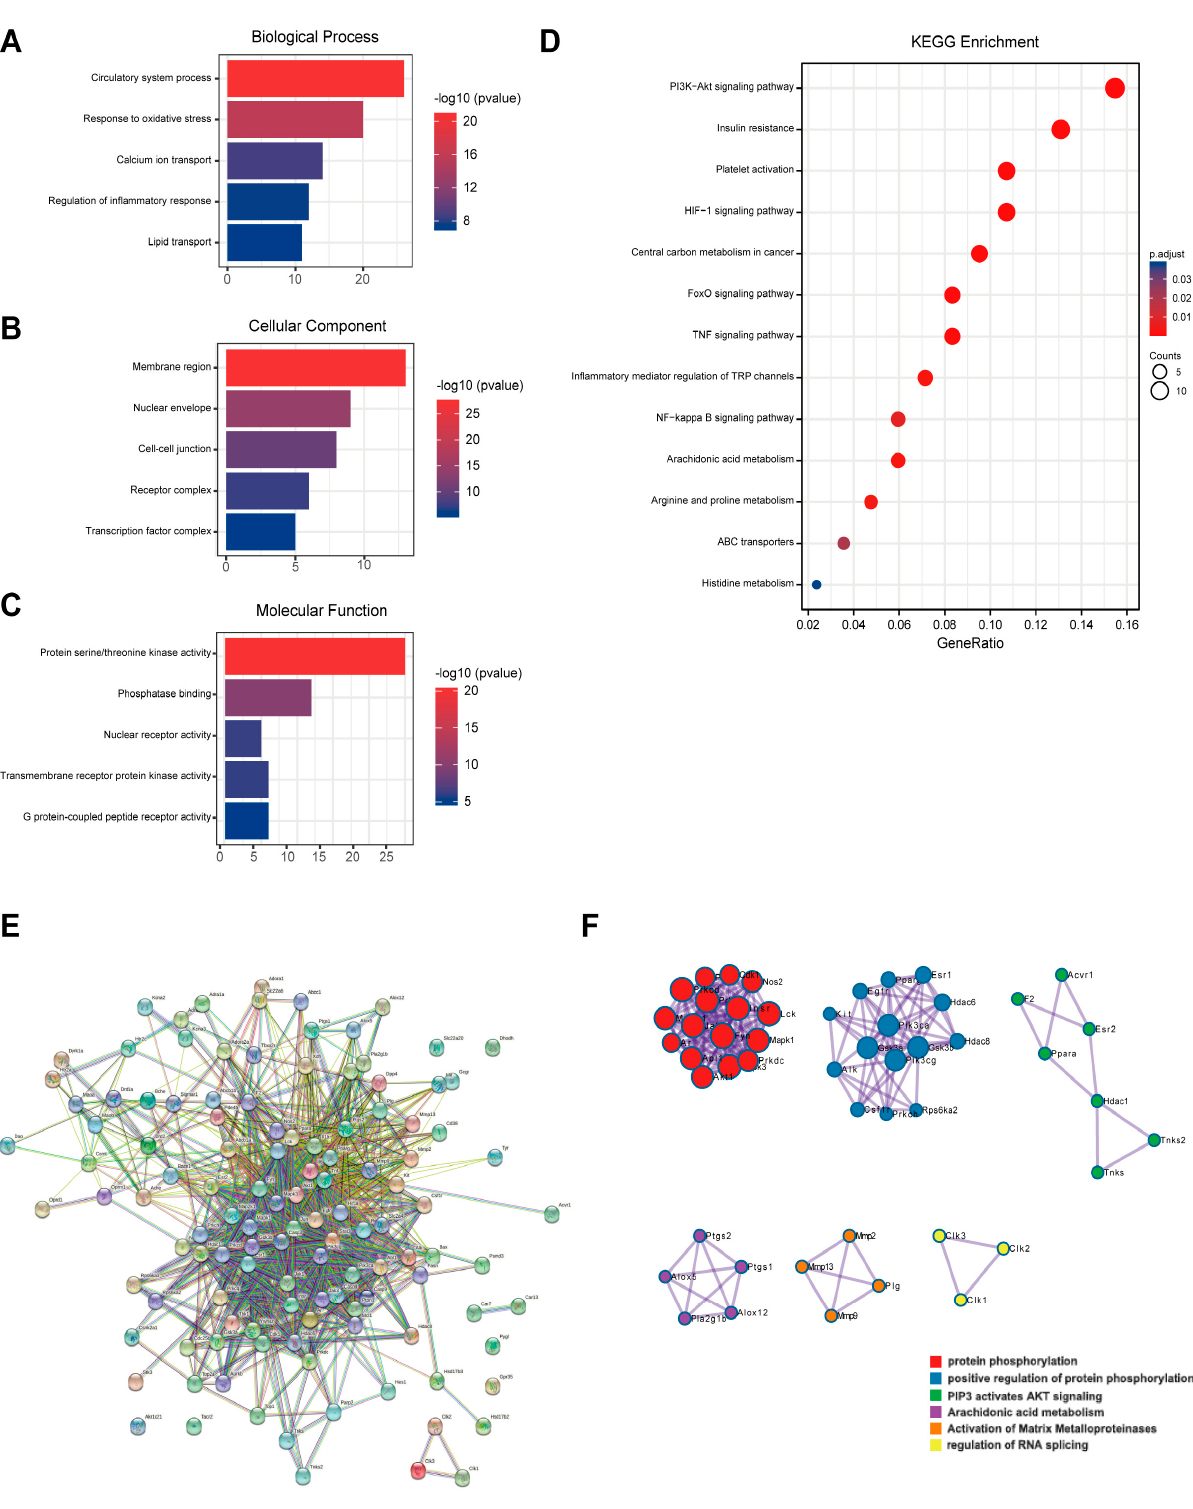
(Figure 8E). In summary, the key targets obtained in the bioinformatics analysis showed significant changes in transcriptional levels for all protein targets, except Ptgs1.